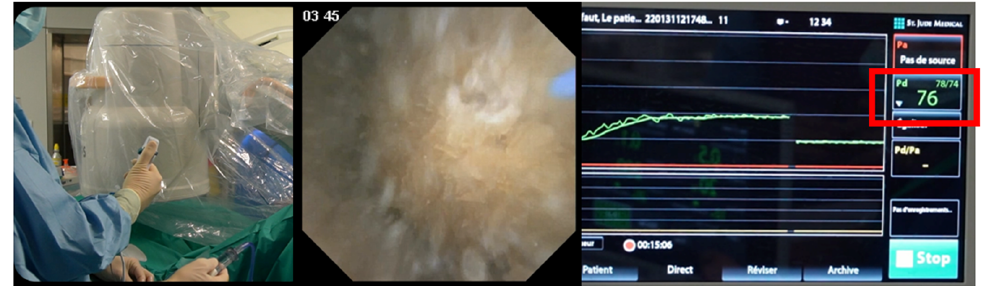
Figure 4. Pressure is simultaneously transmitted to the screen during endoscopic procedure. The pressure is measured in mmHg and the available range is from − 30 to 300 mmHg. In this fi gure, during manual assisted irrigation (Traxerflow Dual Port, Rocamed, Monaco), we achieve IPP at 76 mmHg.